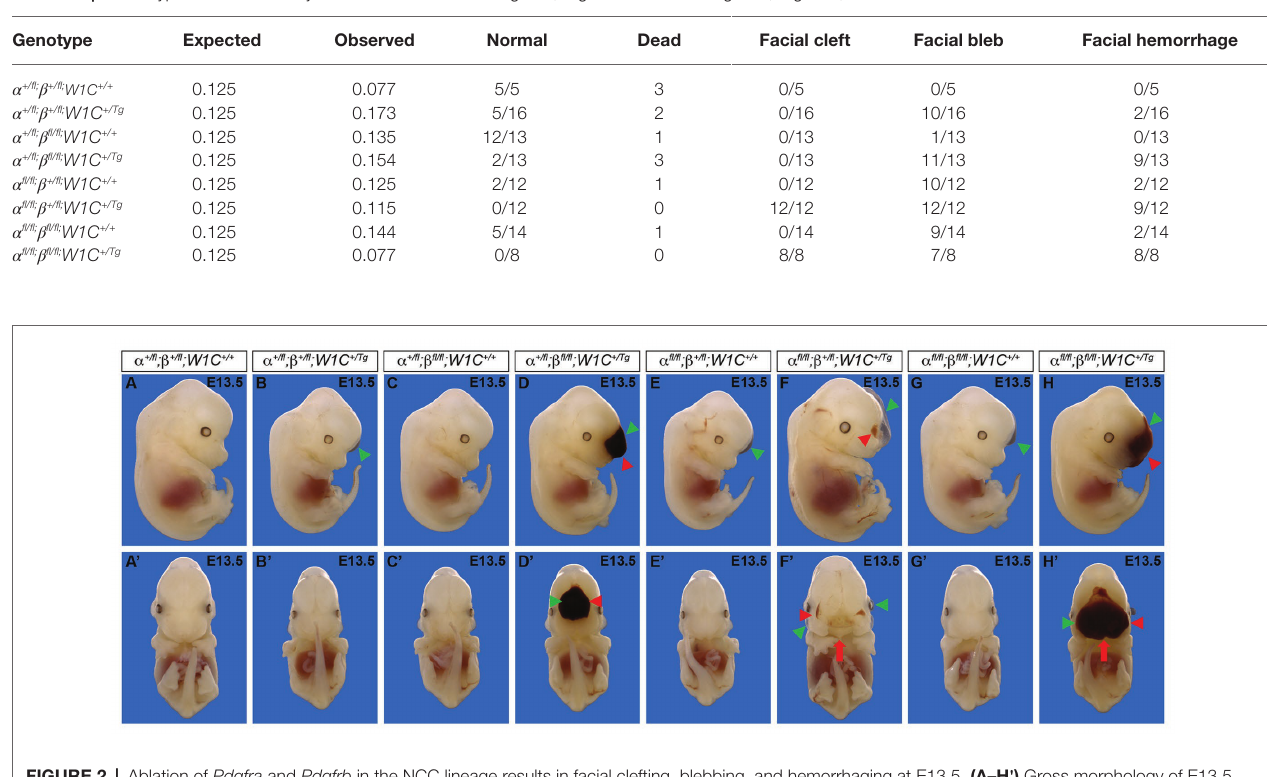
FIGURE 2 | Ablation of Pdgfra and Pdgfrb in the NCC lineage results in facial clefting, blebbing, and hemorrhaging at E13.5. (A–H ' ) Gross morphology of E13.5 embryos resulting from intercrosses of Pdgfra fl/fl ; Pdgfrb fl/fl mice with Pdgfra +/fl ; Pdgfrb +/fl ; Wnt1-Cre +/Tg mice as viewed laterally (A–H) and frontally (A ' –H ' ) . Pdgfra fl/fl ; Pdgfrb +/fl ; Wnt1-Cre +/Tg and double-homozygous mutant embryos exhibited an overt facial cleft (red arrow). Facial blebbing (green arrowheads) and facial hemorrhaging (red arrowheads) were also detected among embryos possessing a variety of allele combinations.